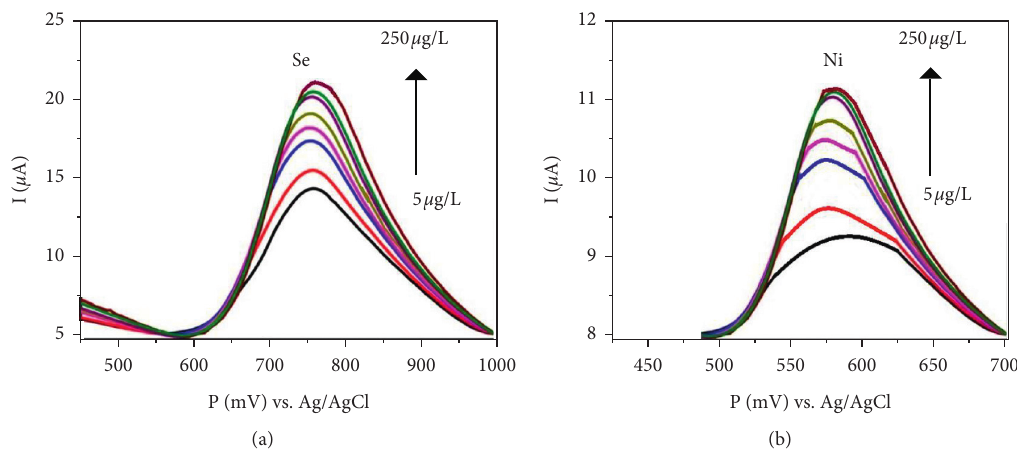
Figure 6: Magnified cyclic voltammetric curves of Se (IV) and Ni (II) for 5–250 µ g/L in 0.1M PBS and 5 mM Fe (CN) 100mV/s by Mn 3 O 4 -Cn electrode at 25 ° C in the range of 400 to 1000mV.